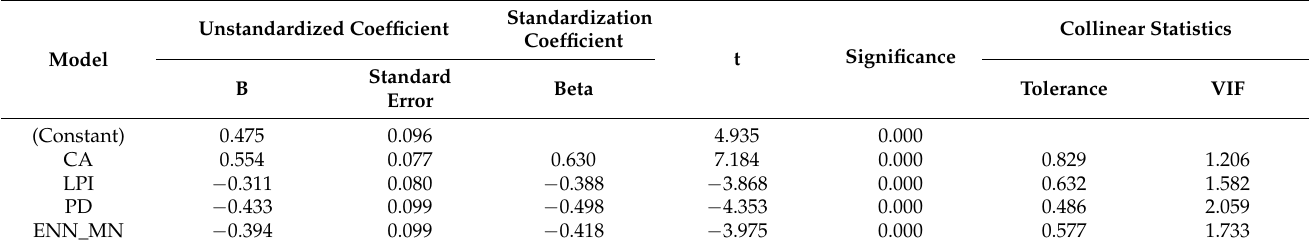
Table 7. Regression results of social spatial form and carbon emission in urban